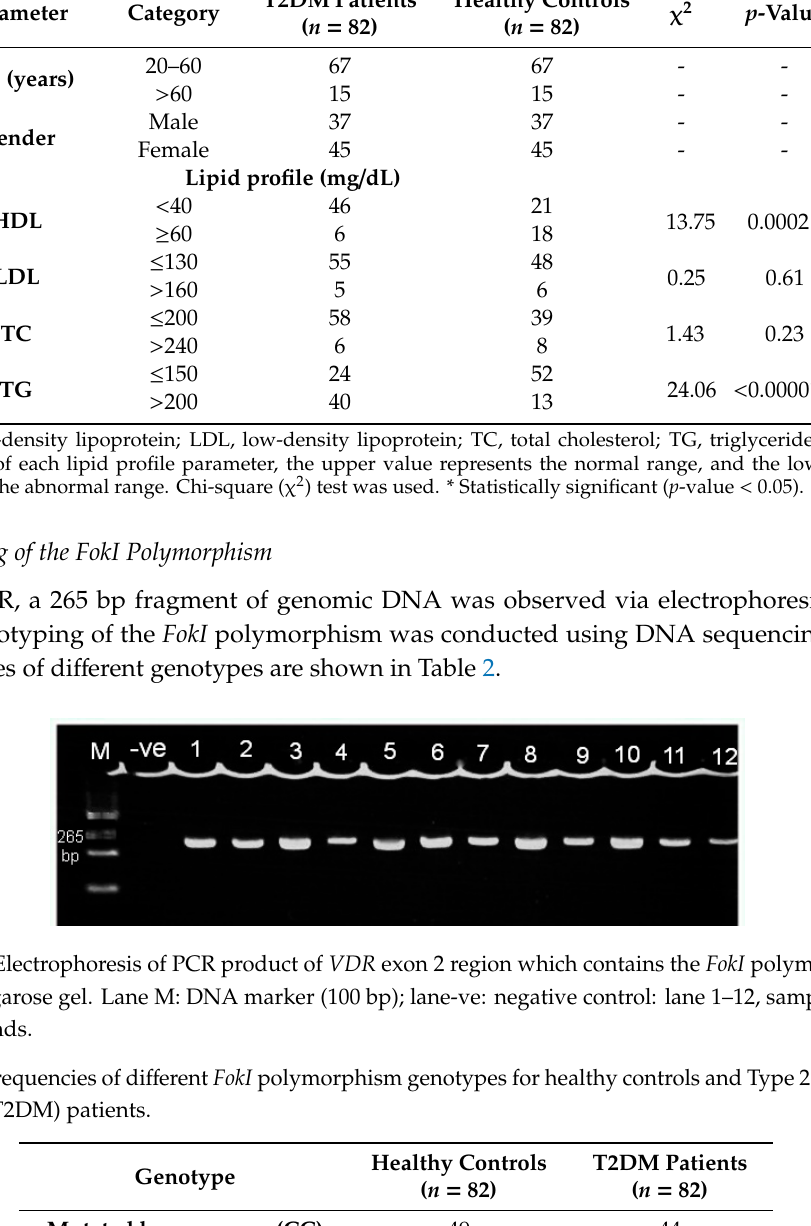
Table 1. Demographic and clinical characteristics of the study population.